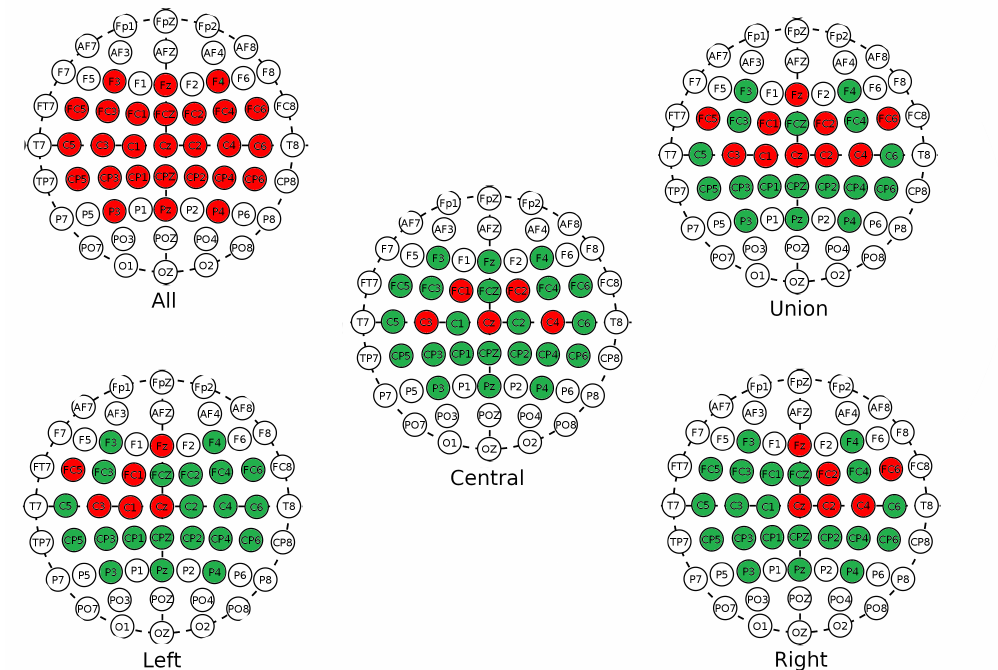
Figure 4. The image shows a map of the electrodes for each configuration analyzed. The positions in green show the recorded EEG electrodes. The red ones indicate which of them were selected for each configuration in the processing